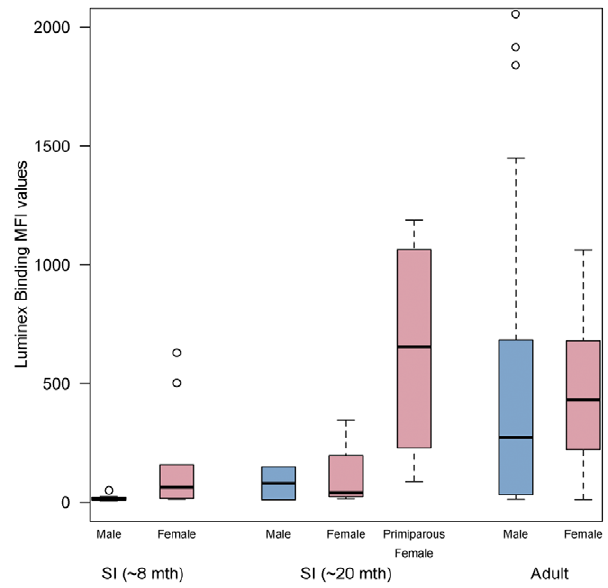
Figure 6. Luminex MFI values against NiV in Eidolonhelvum annobonensis , separated by age and gender. Age is divided into bats of approx. 8 months of age, 20 months of age (including primiparous females) and adults. Graphs are of box and whisker plots showing median (black line), 25th and 75th percentile (box) and 1.5x the interquartile range (dotted line) values.